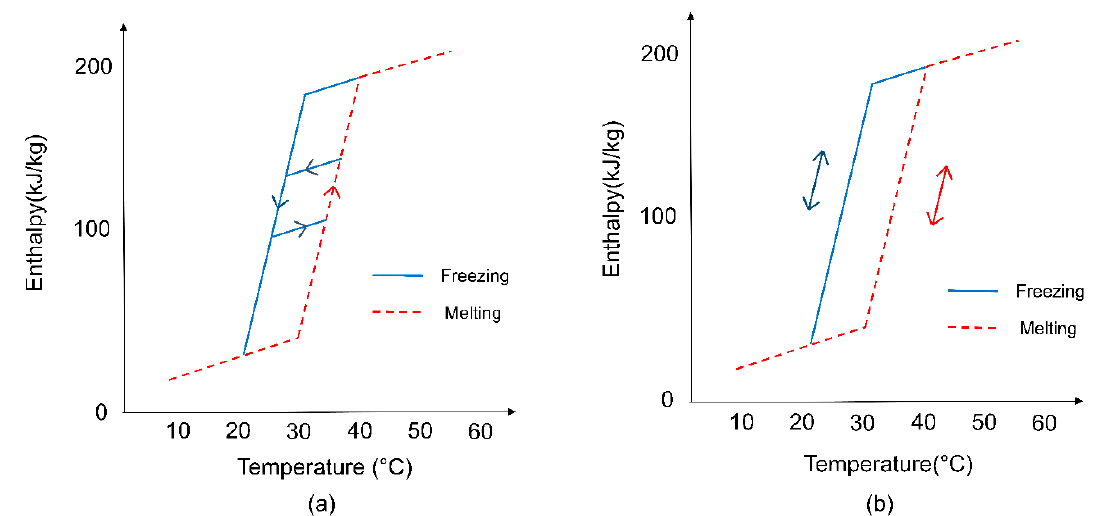
Figure 1. Two approaches to model the transition between melting and freezing processes: ( a ) Straight transition line model; ( b ) One curve model.